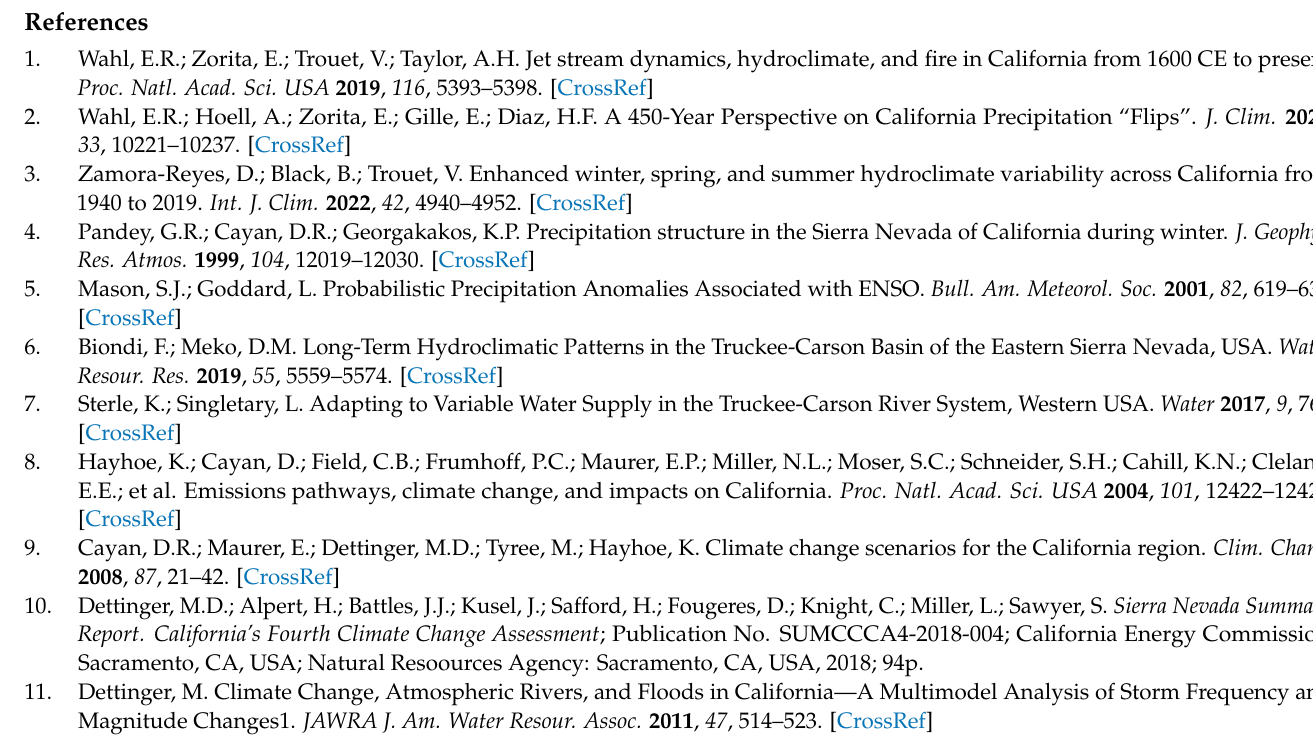
network reconstructions of P12. Figure S6: Mean of monthly P12 precipitation in years of whiplash events in P12. Figure S7: The correlations, 1920–1989, of P12 with full-network and species-specific reconstructions compared with the correlations of P12 with species-mean chronologies for each of the 5 tree species. Table S1: Key for 8 Hydroclimatic series in/near the Truckee-Carson River Basin. Table S2: Summary statistics of single-site reconstructions of P12. Table S3: Significance of whiplash event tracking in P12 by single-site